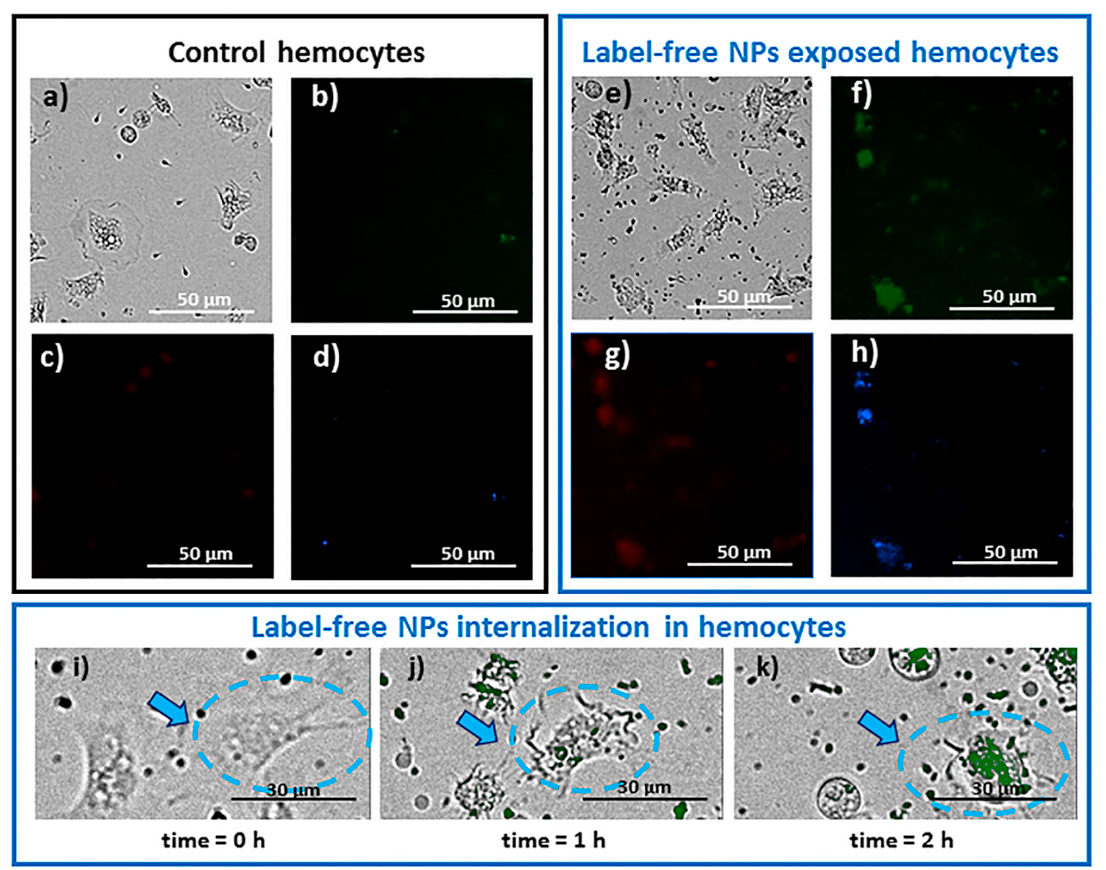
Figure 6. Representative images of control ( a – d ) mussel hemocytes and label-free NPs (10 mg/mL) exposed mussel hemocytes ( e – h ) after 2 h exposure. The cells were imaged by video microscopy using a Cytation 5 imaging multi-mode reader provided with 360/460 nm (blue), 485/528 nm (green), and 523/647 nm (red) filter sets. All images were taken at 40 × magnification; ( i – k ) representative images of mussel granulocytes exposed to 10 mg/mL label-free NPs and observed in the same ROI (region of interest). The arrow indicates the same granulocyte observed at different times (scale bar 30 µ m). The green signal of NPs has been merged with the bright-field image. The internalization of label-free NPs into the Mytilus galloprovincialis hemolymphatic same mussel granulocytes exposed to 10 mg/L label-free NPs with the green signal of